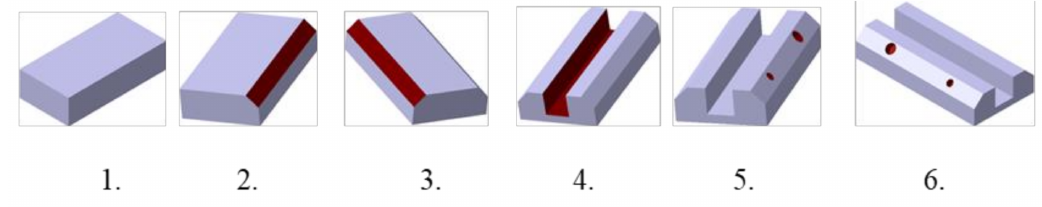
Figure 2. Sequences in manufacturing the generic